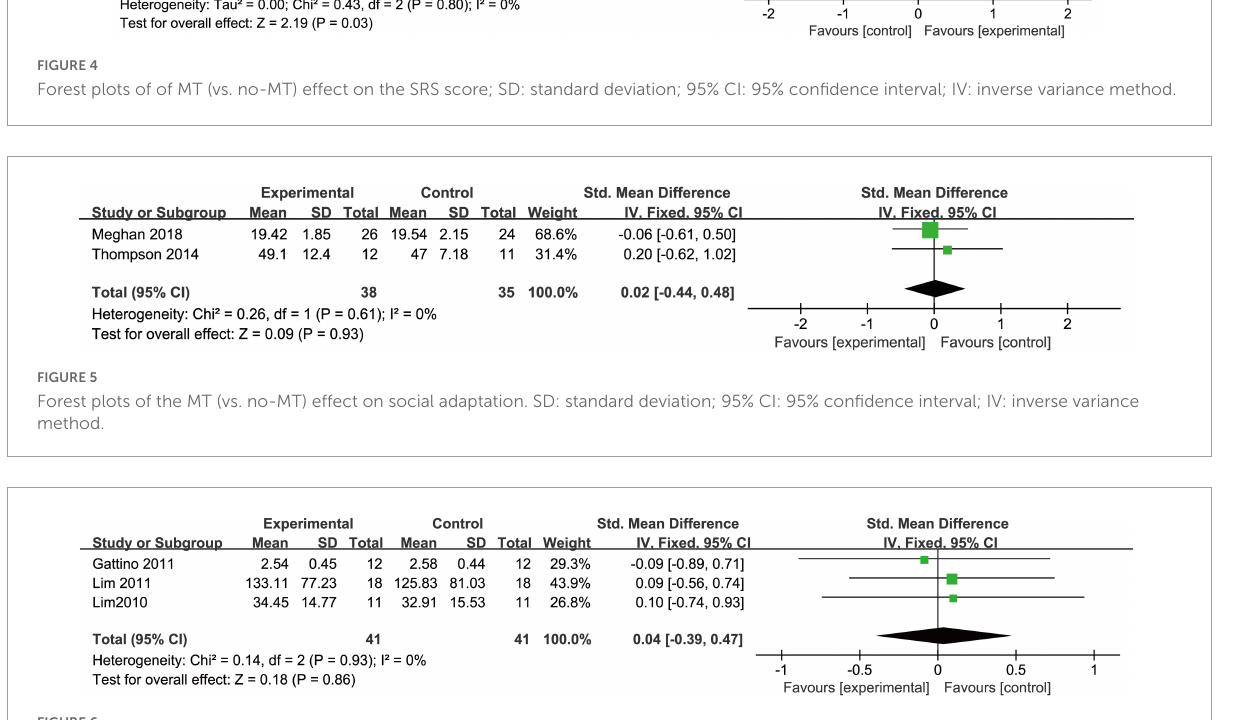
FIGURE6 Forest plots of the MT (vs. no-MT) effect on speech. SD: standard deviation; 95% CI: 95% confidence interval; IV: inverse variance